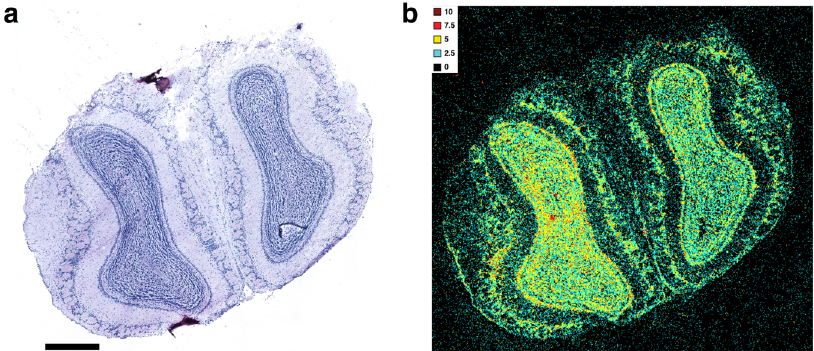
Fig. 2 The sRIN assay measuring short fragments in situ. a HE image (scale bar: 600 µ m) and b sRIN heat map of the same mouse olfactory bulb displayed in Fig. 1d – g, generated from a freshly frozen tissue section after brief formalin (10%) fi xation to simulate fragmentation by cross-linking ( n = 4,